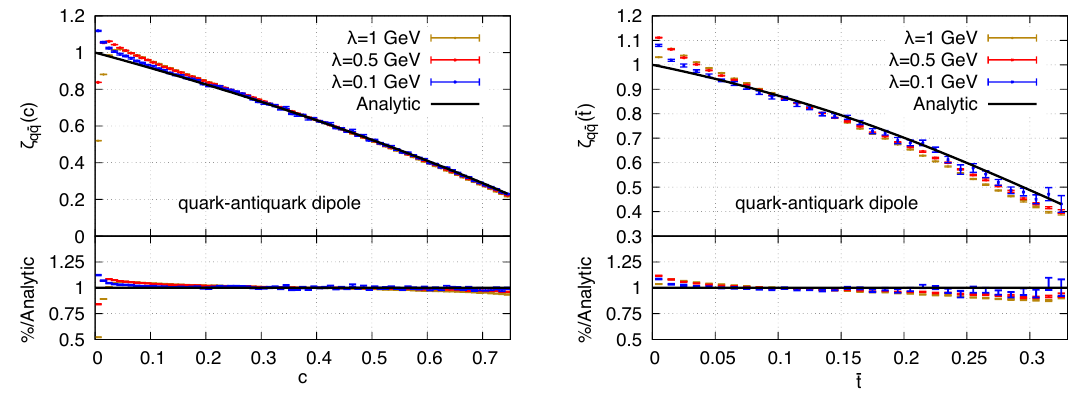
Figure 1 . The function ζ q ¯ q ( v ) for the C -parameter (left panel) and the thrust T = 1 − T (right panel), evaluated numerically using q = 100 GeV and λ = 0 . 1 , 0 . 5 , 1 GeV, compared to the analytic computation (solid line). In the lower panels we reported the ratio plot of each numerical curve with respect to the analytic